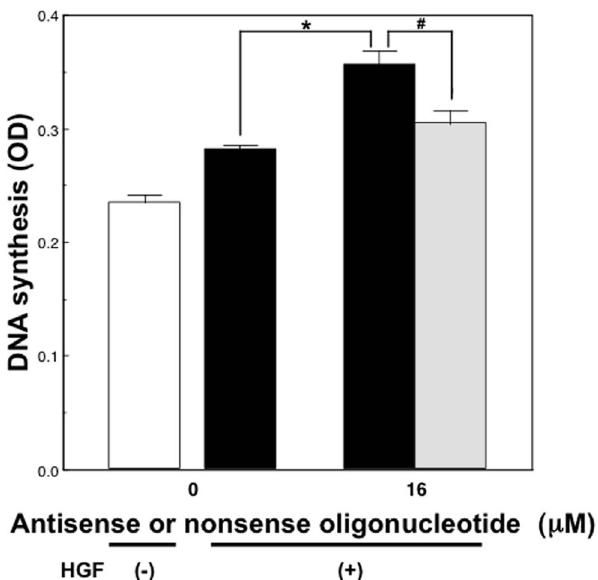
Figure 9. Changes in hepatic p21 levels after two thirds partial hepatectomy in rats. Data are mean 6 SEM of four rats. Open and closed circles indicate the hepatic p21 levels in partially hepatectomized rats and in sham-operated rats, respectively. *p , 0.05 compared with the values at 0 hour, and # p , 0.05 compared with the values of partially hepatectomized